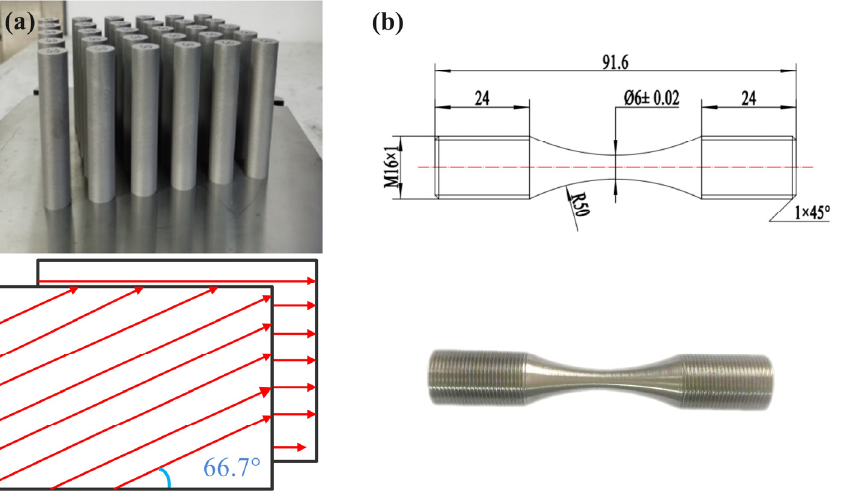
Figure 1. ( a ) The fabricated cylinders Ti-6Al-4V and scanning strategy; ( b ) the threaded cylindrical test specimens.